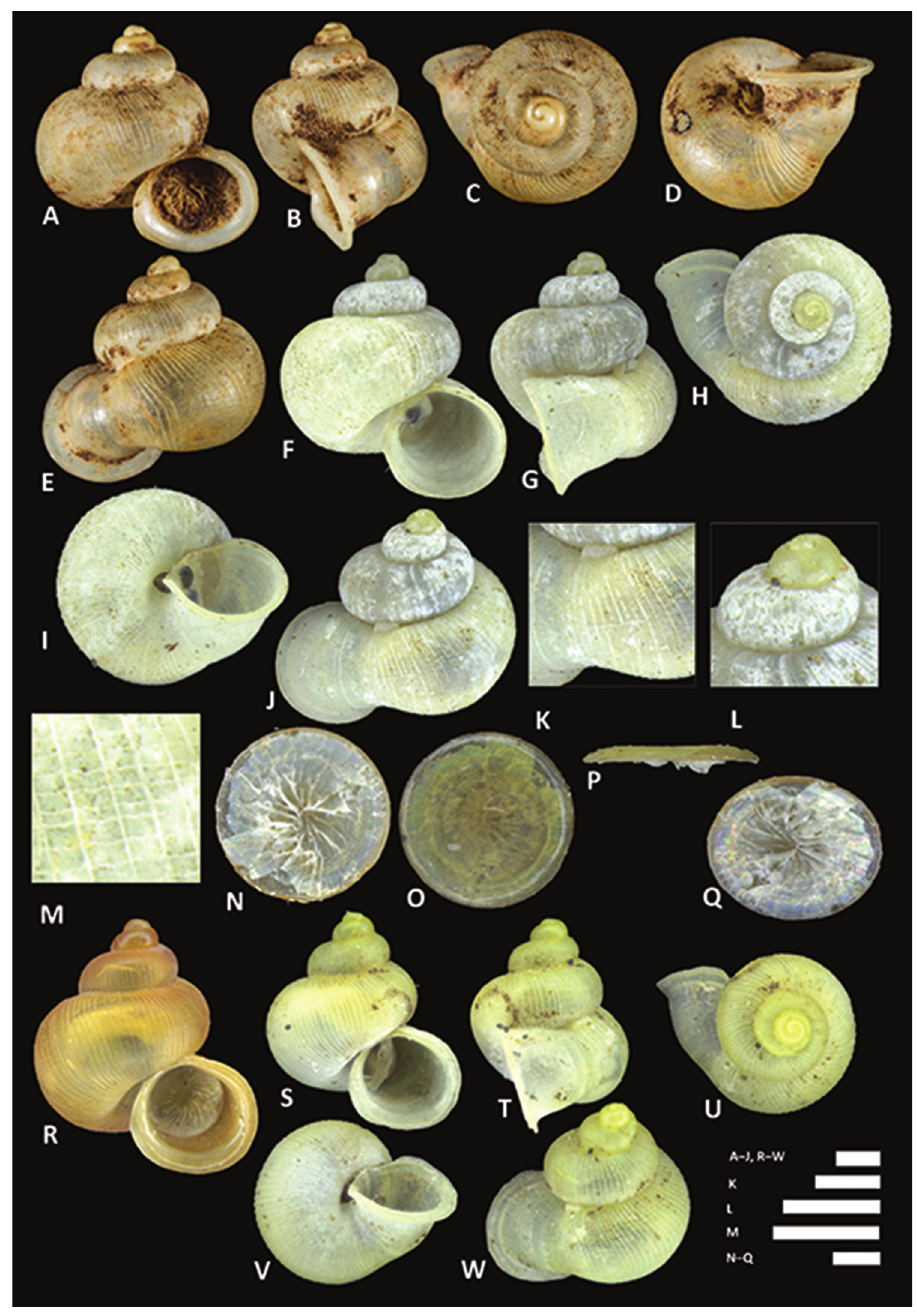
Figure 29. Alycaeus thieroti Morgan, 1885b. A–E Shell of syntype, MNHN-IM-2000-31799 F–J Shell of BOR/MOL 6835 K–M Close up of shell of BOR/MOL 6835 N–Q Operculum of BOR/MOL 6835 R Shell of BOR/MOL 6528a S–W Shell of BOR/MOL 6528b. Scale bars: A–J, R–W 1 mm; K, L 1 mm; M, N–Q 0.5 mm. Photographs A–E by Manuel Caballer (reproduced herein under CC-BY 4.0 license, Project RECOLNAT, MNHN). Photographs F–W by Junn Kitt